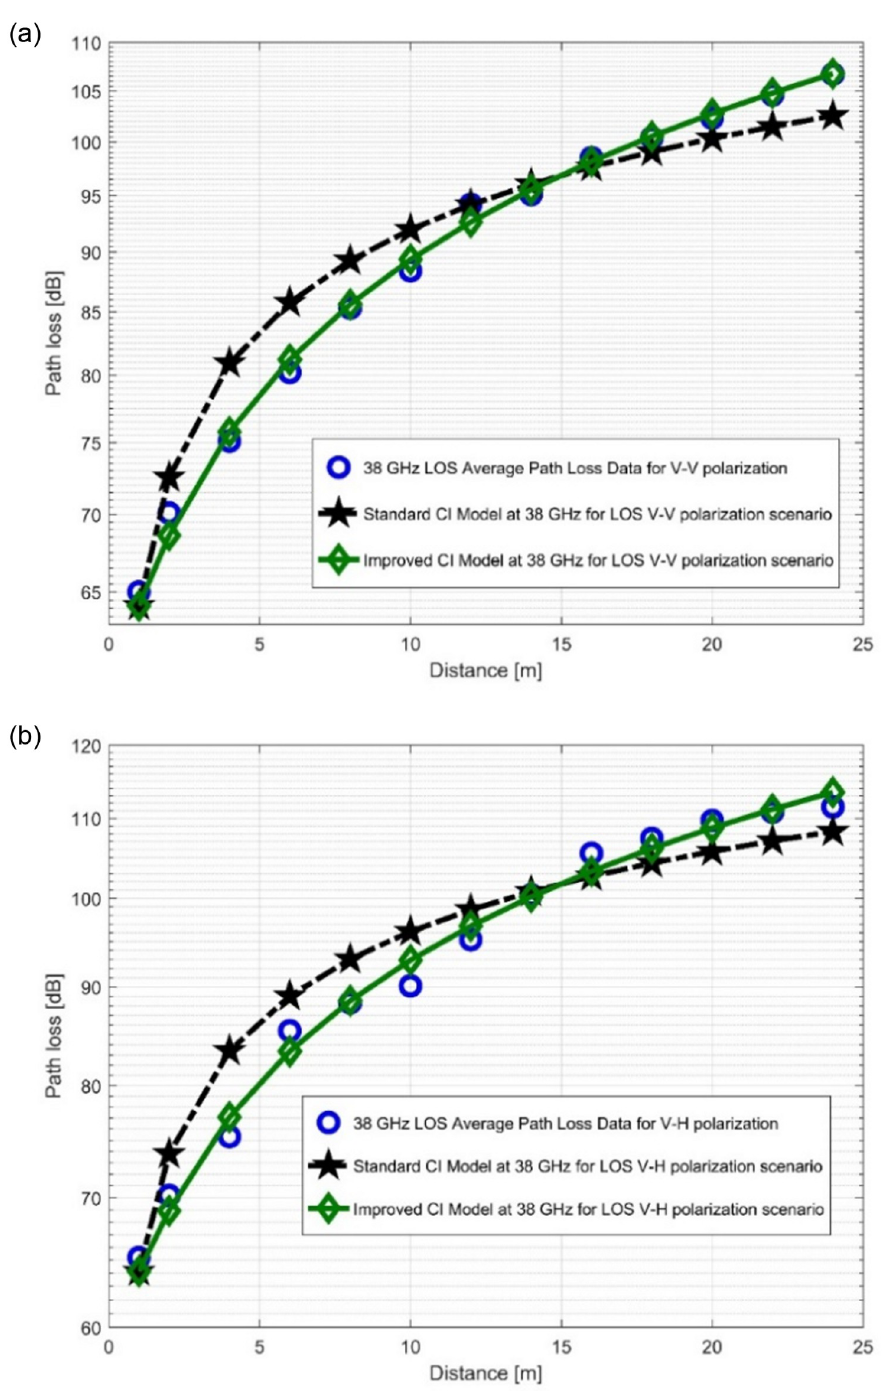
Fig 9. PL vs distance at 38 GHz for the LOS scenario at (a) V-V polarization, (b) V-H polarization.